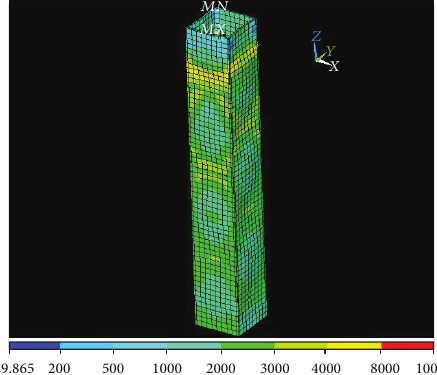
Figure 25: Typical computed deformed shapes of HS-50-20-T3.